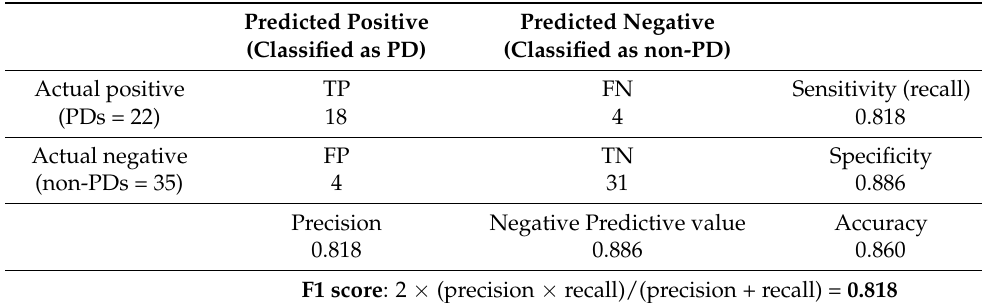
Table 3. Confusion matrix of ANN classifier for predicting PD.